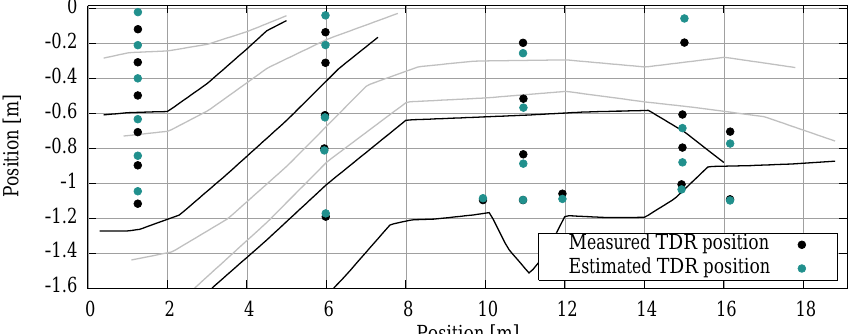
Figure 5. The subsurface architecture of ASSESS (Fig. 2) is shown with a comparison of measured and estimated TDR sensor positions based on a first evaluation of the hydraulic measurement data. The consistent deviation of the estimated TDR sensor positions reveals an unrepresented model error: the orientation of ASSESS (Sect.